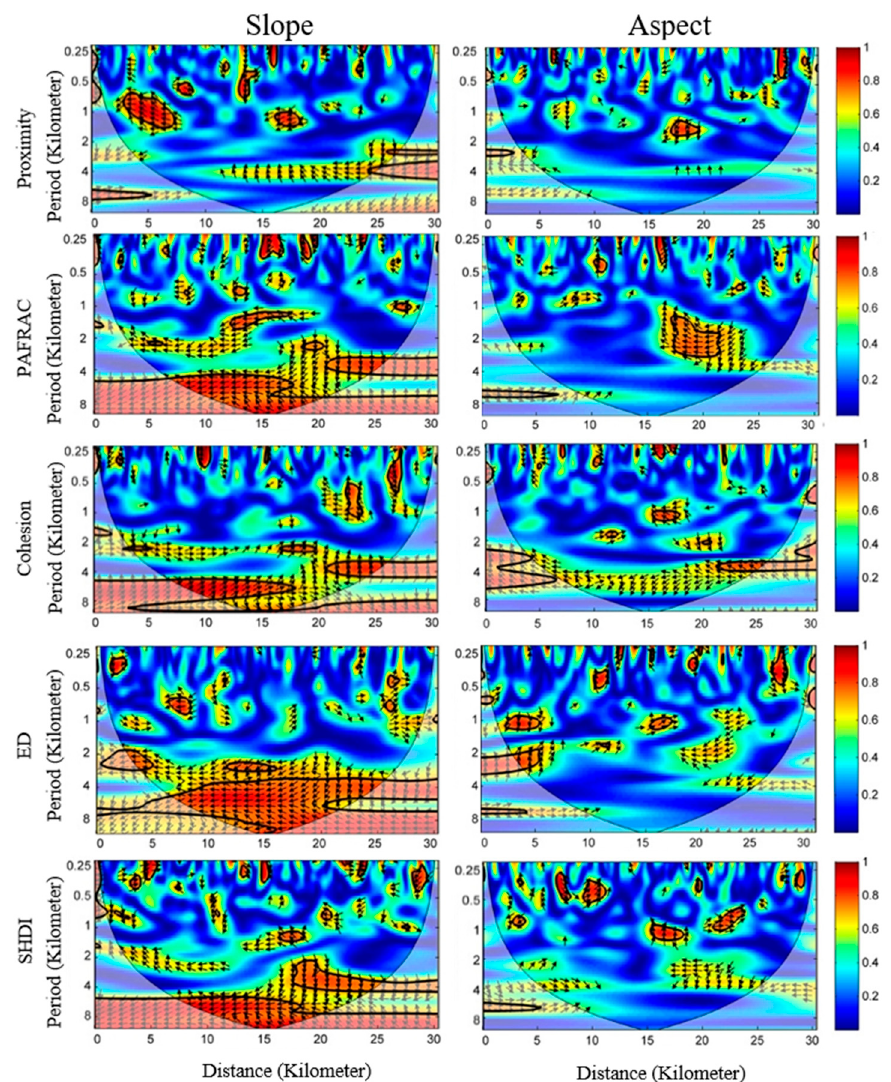
Figure 5. The wavelet coherencies between landscape metrics and other topographical factors (slope and aspect) in profile A.